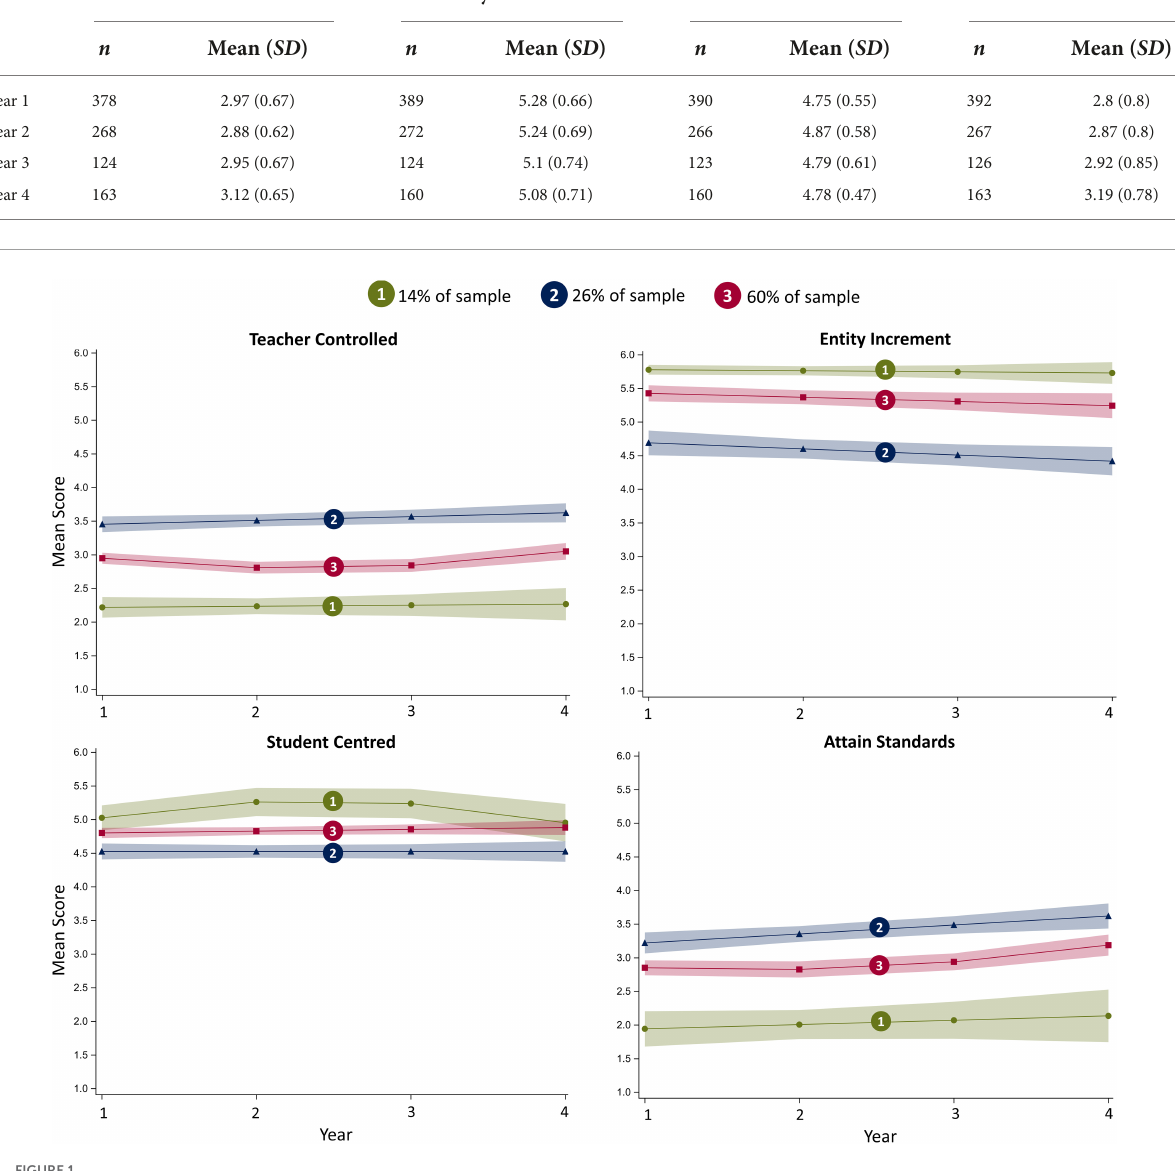
FIGURE1 Mean trajectory of each beliefs domain over time. Band around each trajectory represents the 95% confidence interval.